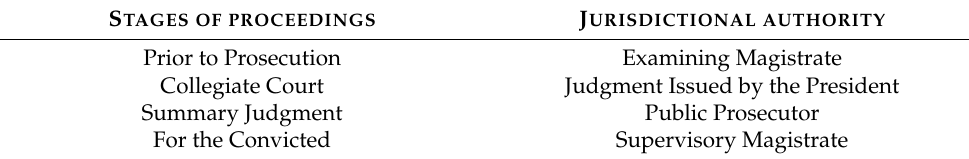
Table 1. Jurisdictional authority in the protection of prisoner health throughout the various stages of